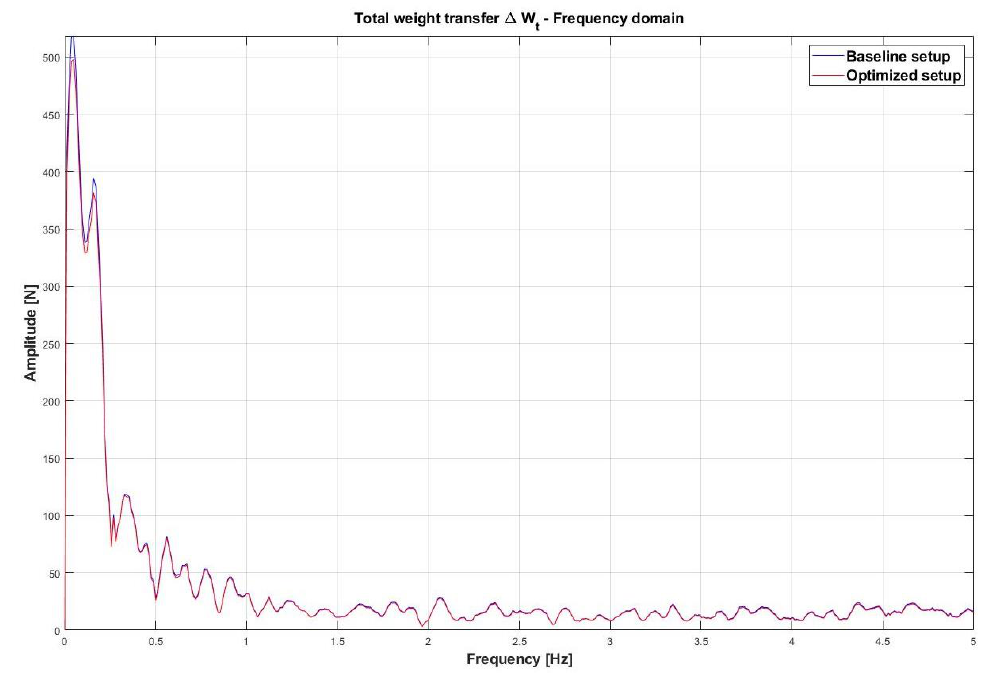
Figure 27. Comparison between the baseline provided setup and improved setup for the total weight transfer of the car in the frequency domain.